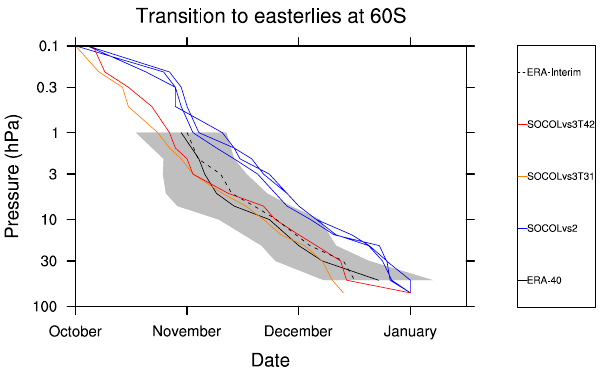
Fig. 3. Timing of transition from westerlies to easterlies (indicat- ing the breakdown of the Antarctic vortex) at 60 ◦ S for ERA-40 (solid black line), ERA-Interim (dashed black line), SOCOLvs2 (blue lines), SOCOLvs3 T31 horizontal resolution (orange line), and SOCOLvs3 T42 horizontal resolution (red line). Grey shading indicates ERA-40 plus and minus 1 standard deviation about the climatological mean